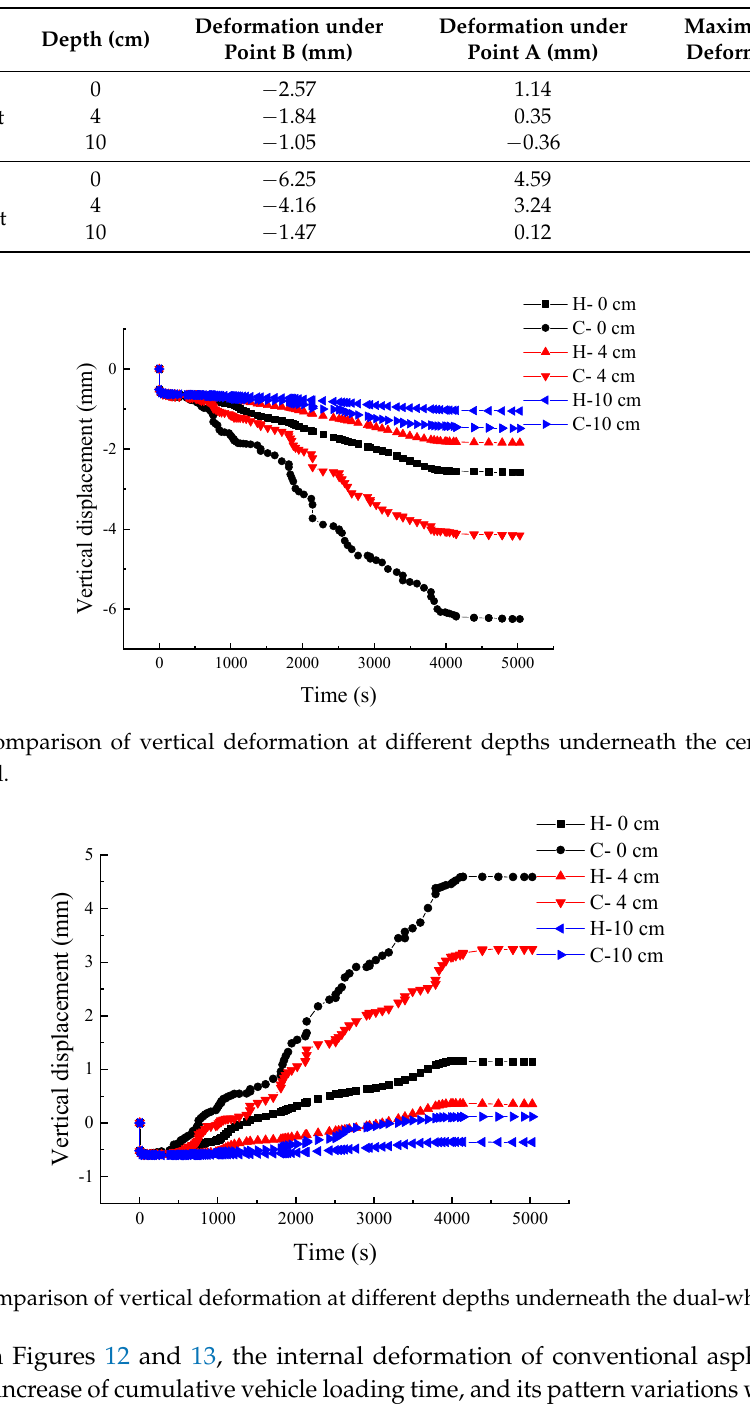
Conventional asphalt pavement Figure 14. Comparison of the relative maximum deformation of two types of pavement at different depths. From Table 13 and Figure 14, it can be seen that the deformation values of the conventional asphalt pavement at different depths were much higher than those of the HMAC pavement. At the road surface, the maximum relative deformation of conventional asphalt pavement was 10.84 mm, which was 7.13 mm higher than that of HMAC, and the difference in deformation values was the largest. The second-highest difference in deformation was 5.21 mm at the bottom of the upper surface layer. At a depth of 10 cm, although the vertical deformation was small, the maximum relative deformation of the conventional asphalt pavement was 1.59 mm. This was an increase of